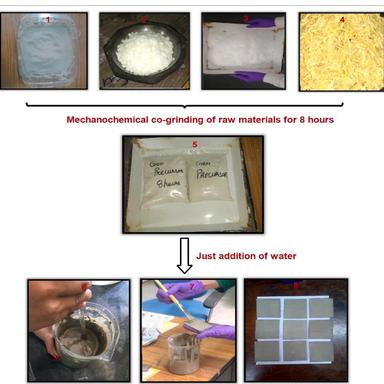
Raw materials and flow chart for coating hybrid inorganic-organic geopolymeric materials on mild steel. 1- fly ash, 2- sodium hydroxide pellets, 3- sodium metasilicate, 4- rice husk, 5- geopolymeric precursor powder obtained after 8 h together mechanochemical dry grinding of raw materials in different weight ratios, 6- advanced geopolymeric gel formed after just addition of water to precursor material, 7- coating of material on substrate by paint brush method and 8- mild steel substrates with completely dri